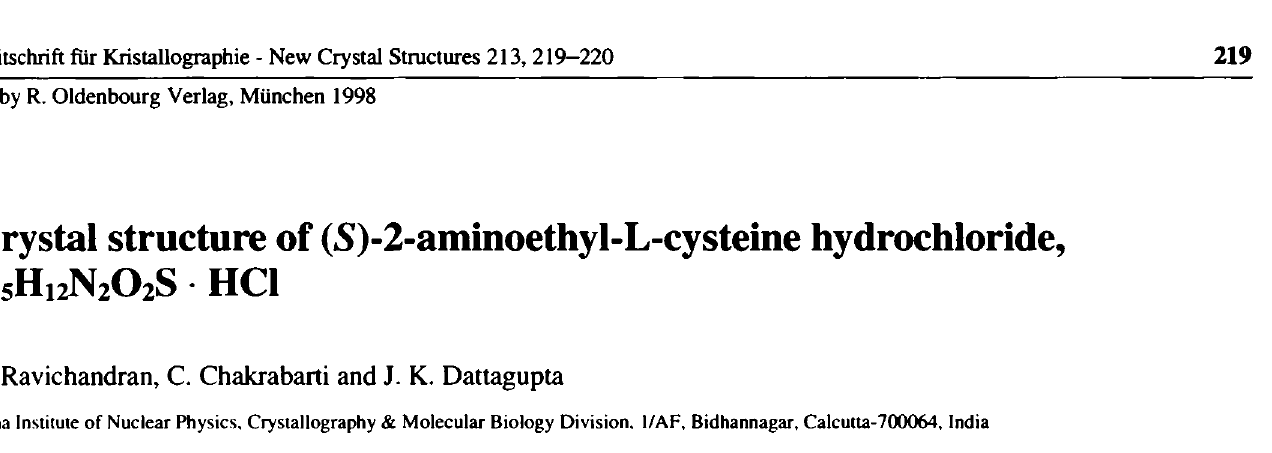
Table 1. Parameters used for the X-ray data collection